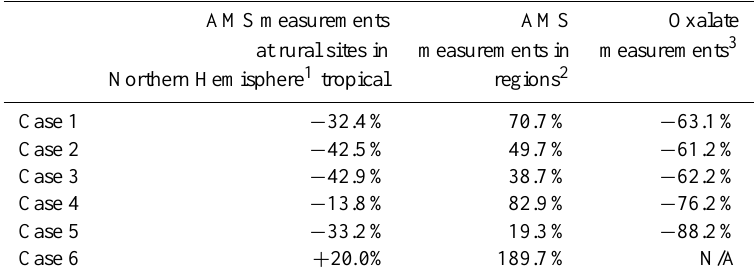
Table 8. Comparison of the normalized mean bias (NMB) between observations and the model results for different